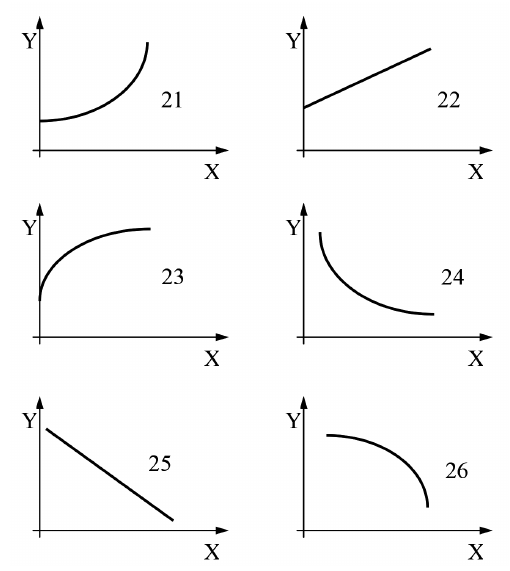
Figure 2. Examples of qualitative pair wise relations Source: authors’